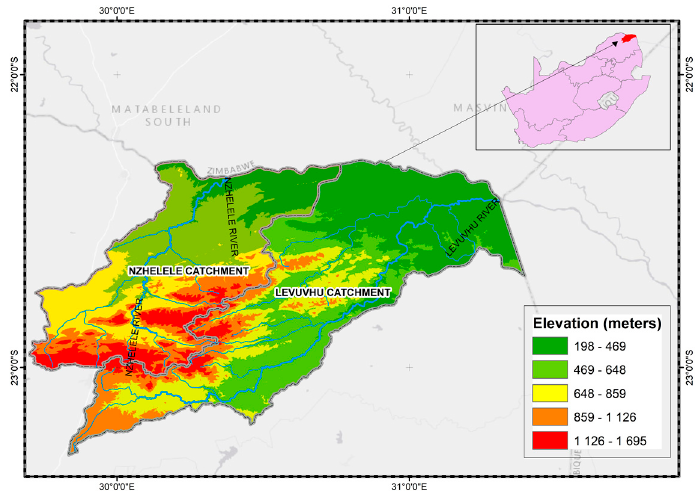
Figure 1. Location of study